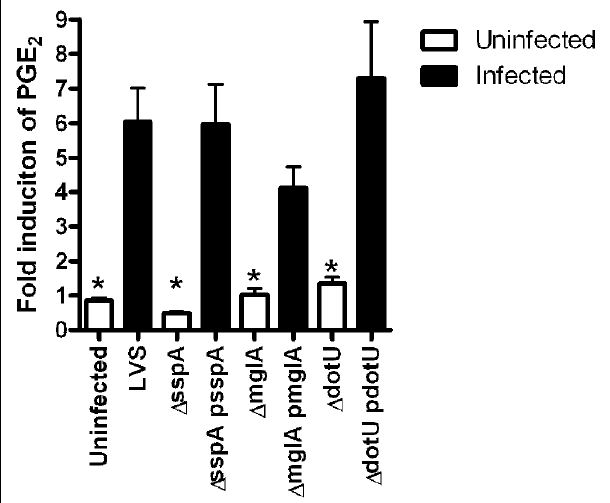
FIGURE 3 | mglA , sspA , and dotU are necessary for LVS induction of PGE 2 synthesis. Bone marrow-derived macrophages were inoculated with LVS, LVS Δ mglA , LVS Δ mglA ( pmglA ), LVS Δ sspA , LVS Δ sspA ( psspA ), LVS Δ dotU , LVS Δ dotU ( pdotU ), or LVS at an MOI of 200:1. Twenty-four hours after inoculation the levels of PGE 2 were determined. Experiments were done in triplicate; error bars represent SEM ( n =